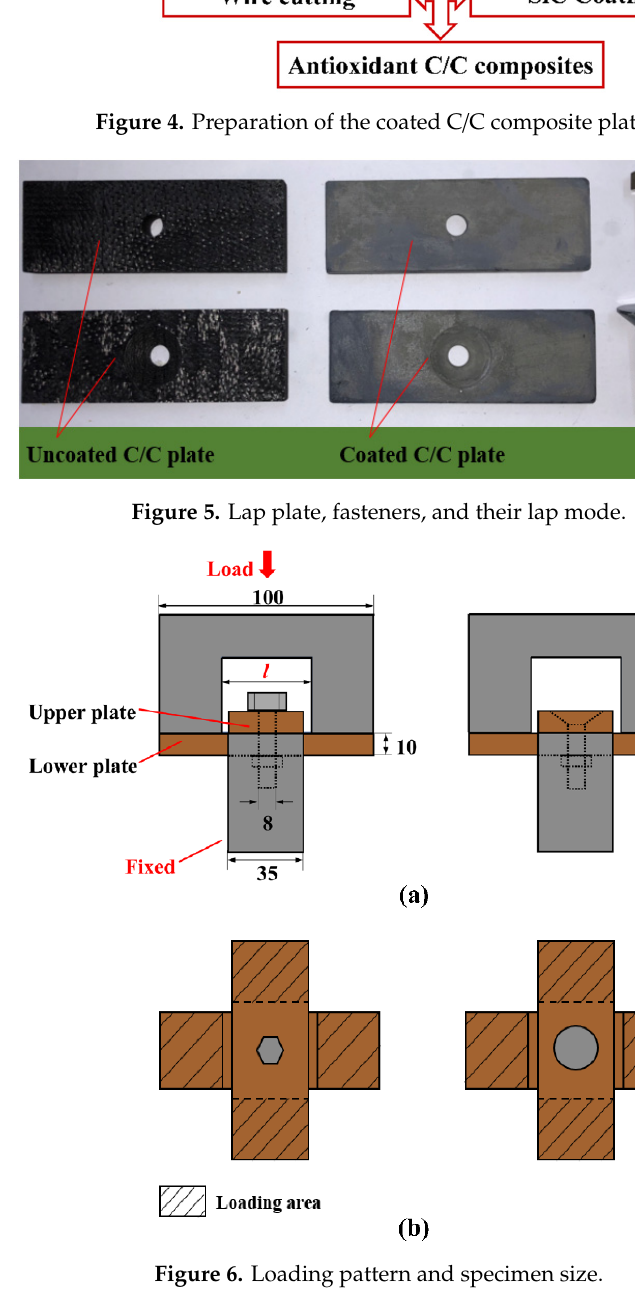
Figure 6. Loading pattern and specimen size.